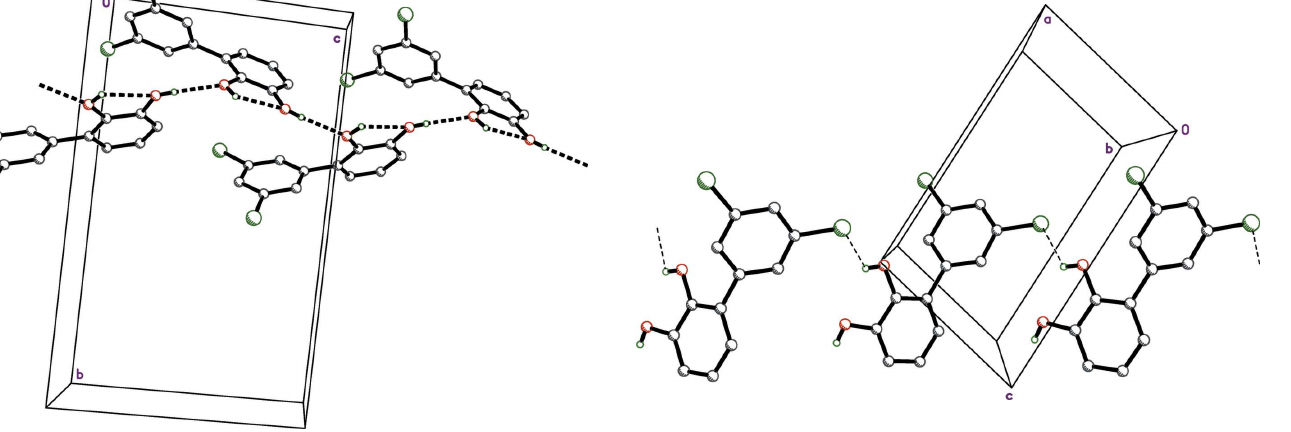
Figure 3 A packing plot viewed approximately along the b axis. Intermolecular hydrogen (cid:3)(cid:3)(cid:3) chlorine interactions are drawn as thin dashed lines. For information regarding the hydrogen-bond geometry, see Table 1.